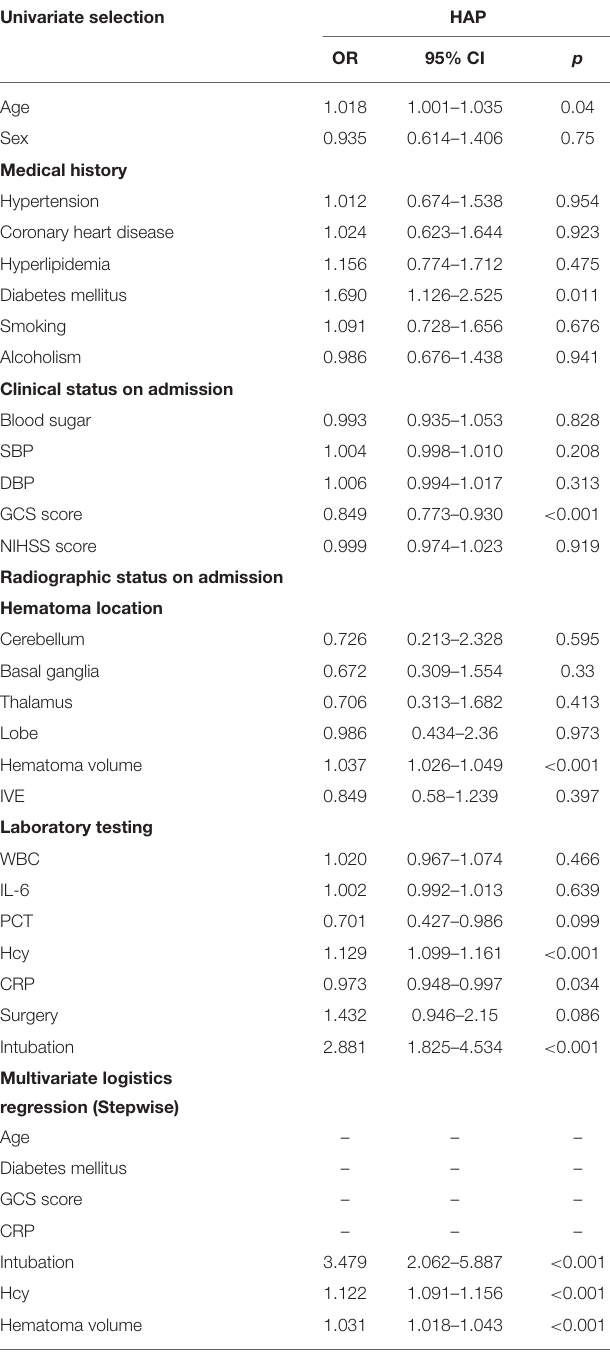
revealed significant differences in the history of diabetes mellitus